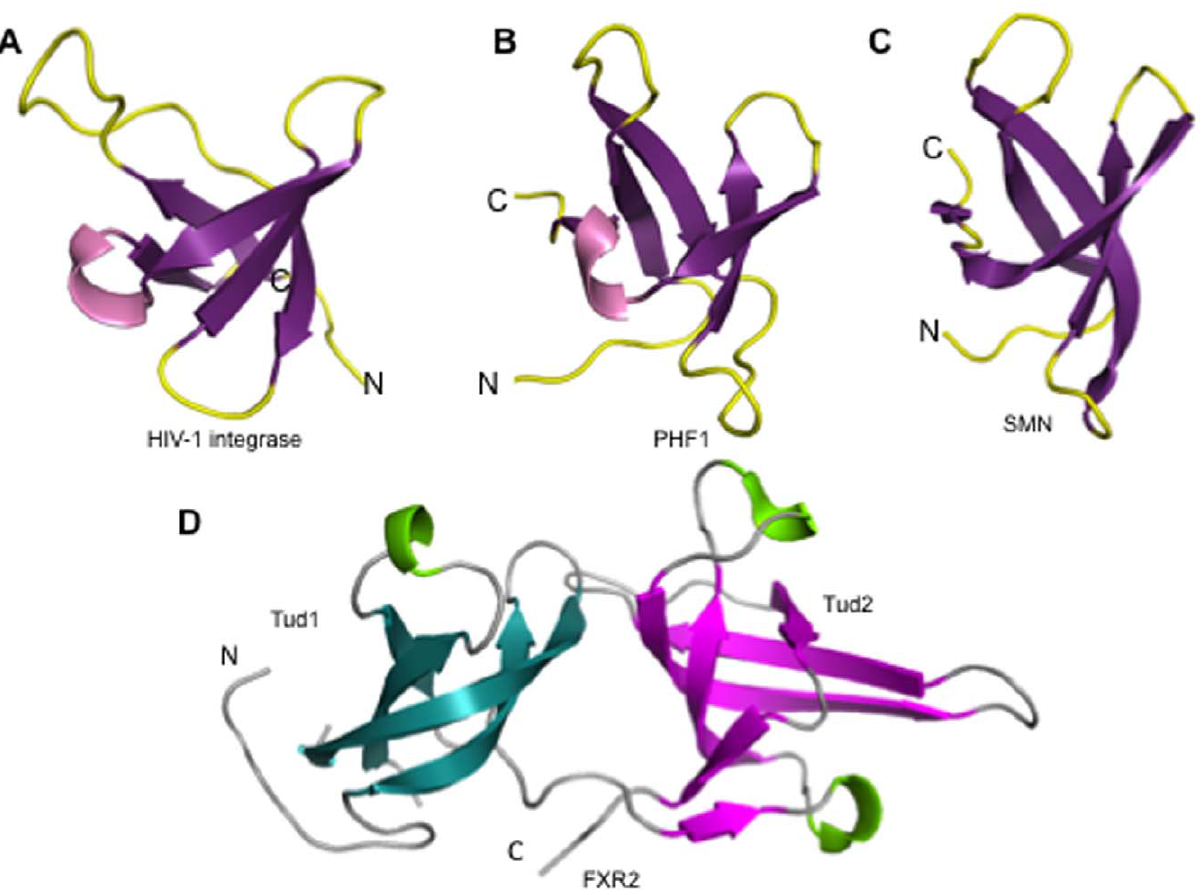
Figure 2. Structural similarity of the Fragile X Tudor domains with other b -barrel proteins. 3D Structures of: (A) the DNA binding domain of the HIV-1 integrase (PDB 1IHV); (B) the Tudor domain of the PHD finger protein 19 (PDB 2E5Q); (C) the Tudor domain of the human SMN protein (PDB 1G5V). These three structures are shown in the same orientation based on superposition. (D) Crystal structure of FXR2 is shown for comparison. The first Tudor (tud1) is colored in cyan and the second Tudor (tud2) is colored in